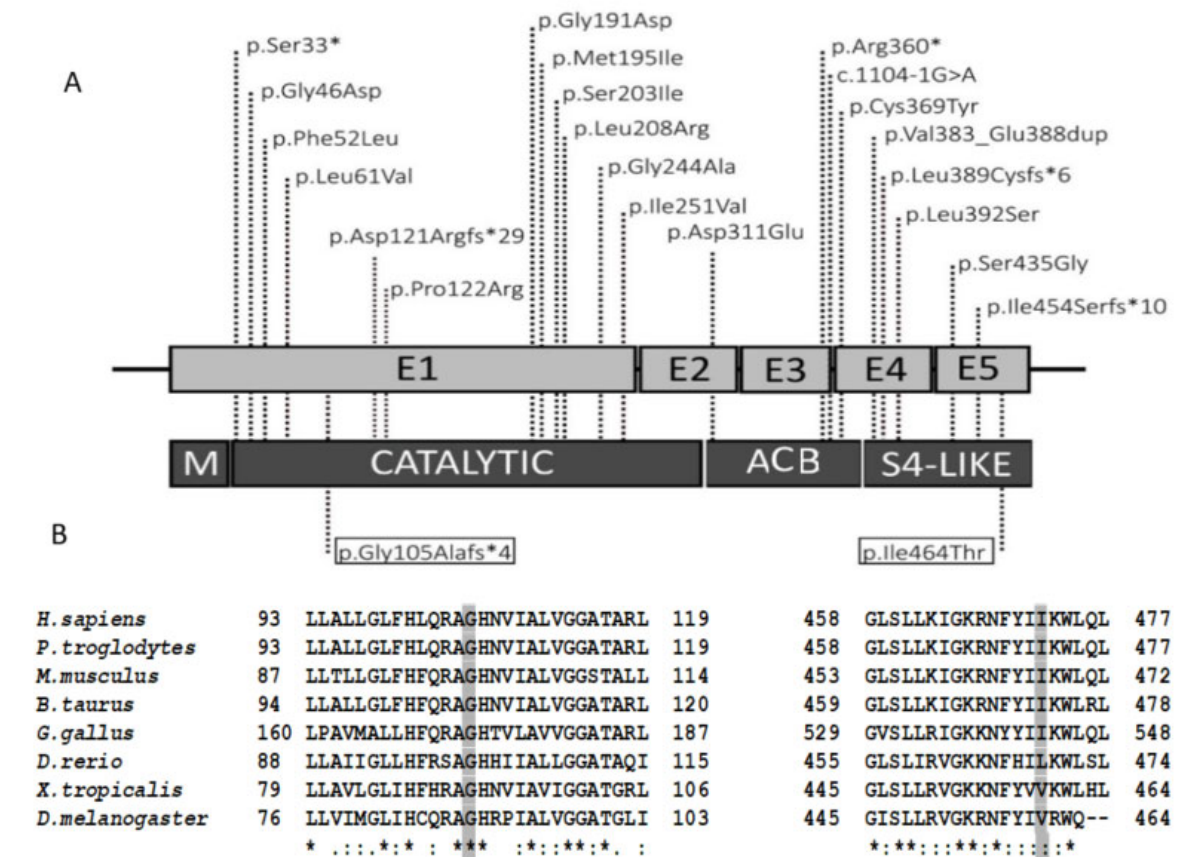
Figure 1. YARS2 reported variants and evolutionary conservation. ( A ) Summary of the known YARS2 pathogenic variants and their distribution. The two new variants are boxed within highlighted squares. E (exon), M (mitochondrial target sequence), CATALYTIC (catalytic domain), ACB (anticodon binding domain), region S4-LIKE, (ribosomal protein S4-like protein). ( B ) Amino acid conservation study. CLUSTAL online software amino acid alignment of the YARS2 regions containing the new variants. The patient’s mutated residues are shadowed, and the conserved residues are indicated with an asterisk (*).